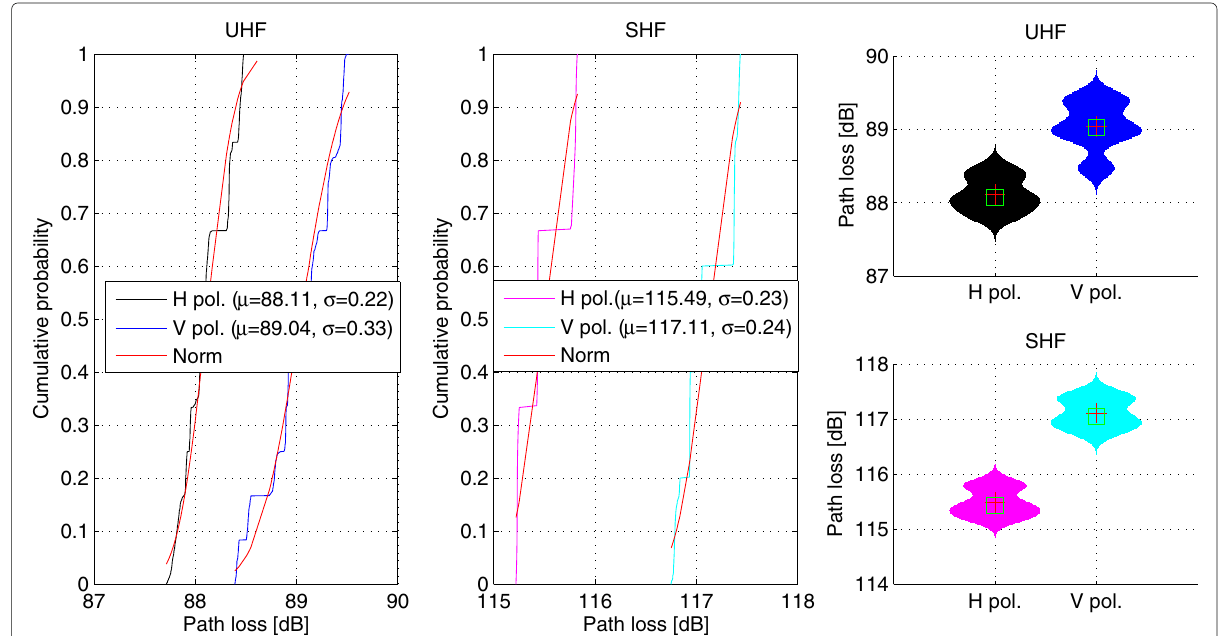
Fig. 6 Cumulative Distribution Function of the measured path loss in a line of sight environment. Both 1.3 and 5.8 GHz signals with horizontal and vertical co-polarizations antenna settings were transmitted. The curve colored in red represents the Normal